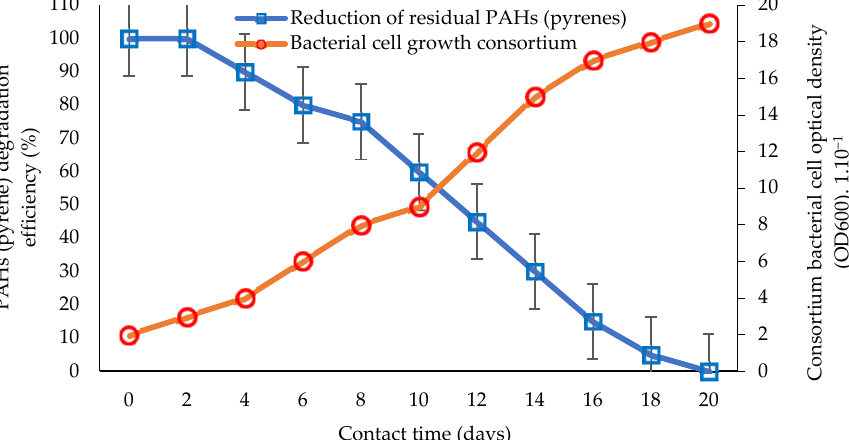
Figure 2. Comparison of the percentage of PAH (pyrene) bioremediation with the bacterial cell growth rate of the consortium based on interaction time. Graphically modified figure [51,64,71,113,116].